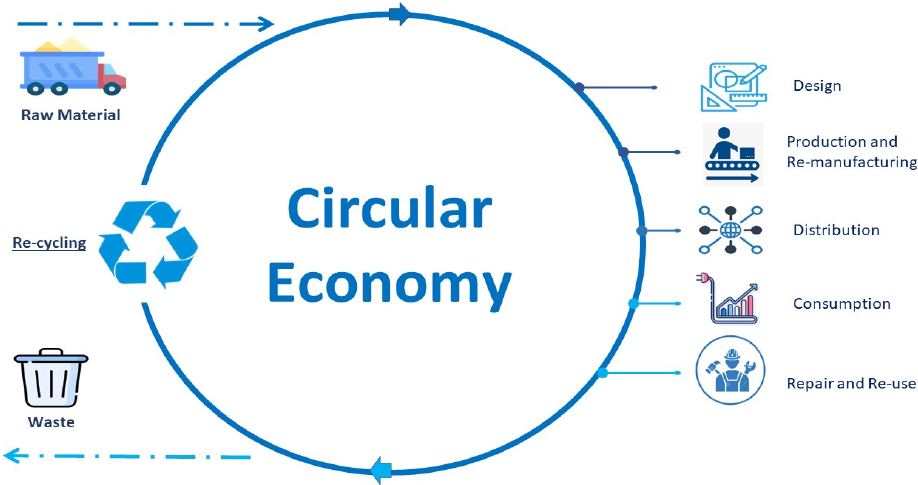
Figure 1. Circular Economy Model.